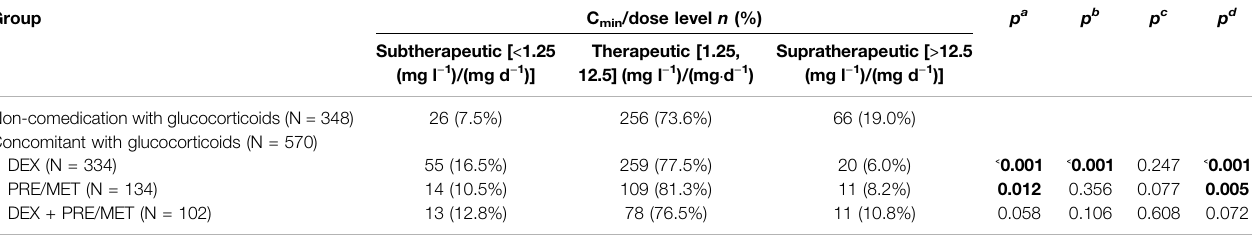
TABLE 3 | The effect of glucocorticoids on in fl uencing probability of the therapeutic window of VRC. Group C min /dose level n (%) p a p b p